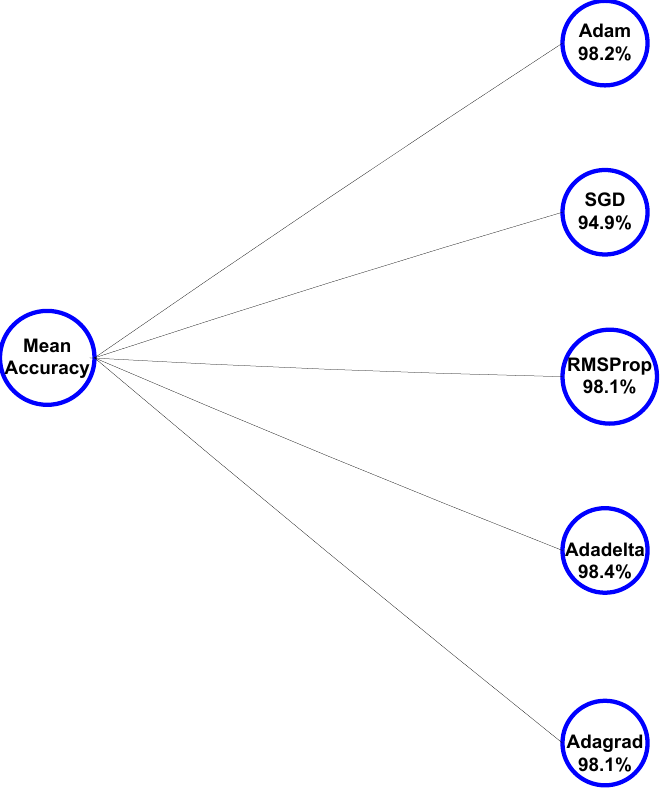
Figure 3. The mean accuracies of the various optimizers.